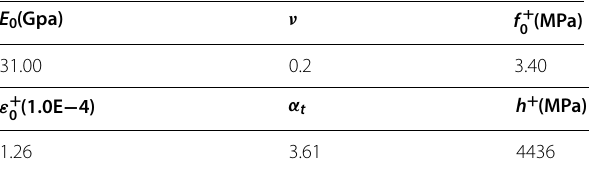
Table 2 Material constants identified from the experiment results of Taylor (1992).